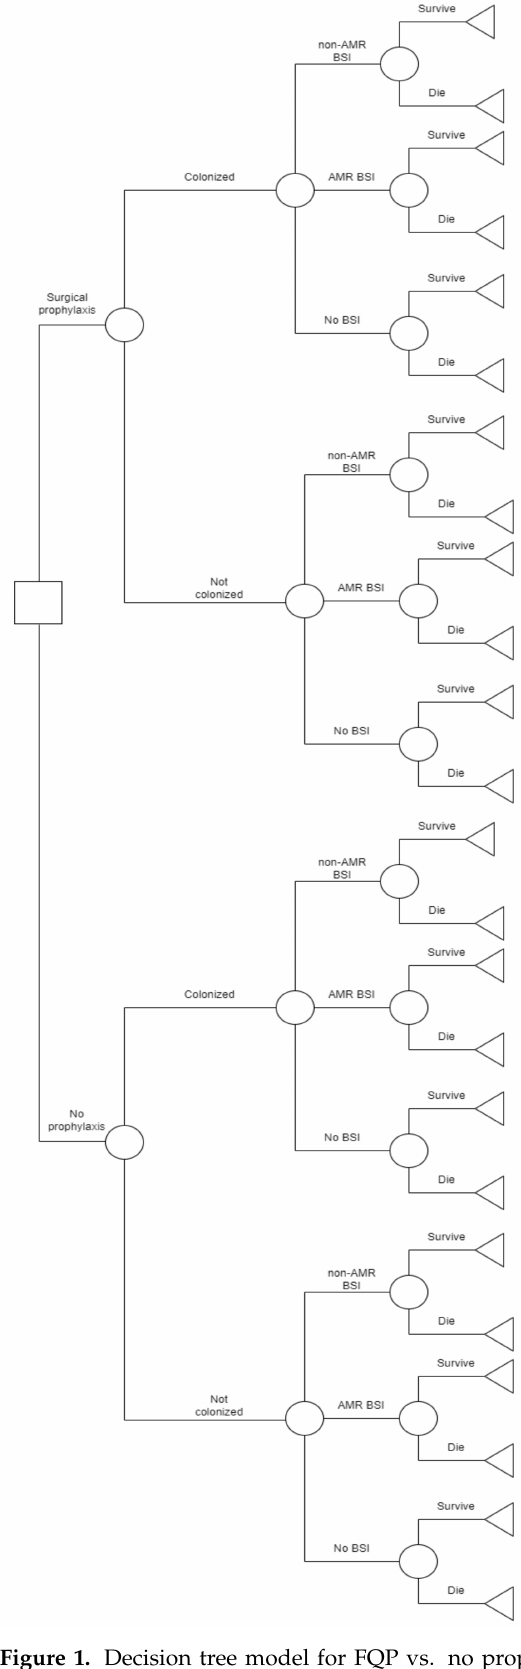
Figure 1. Decision tree model for FQP vs. no prophylaxis. AMR: antimicrobial resistance; BSI: bloodstream